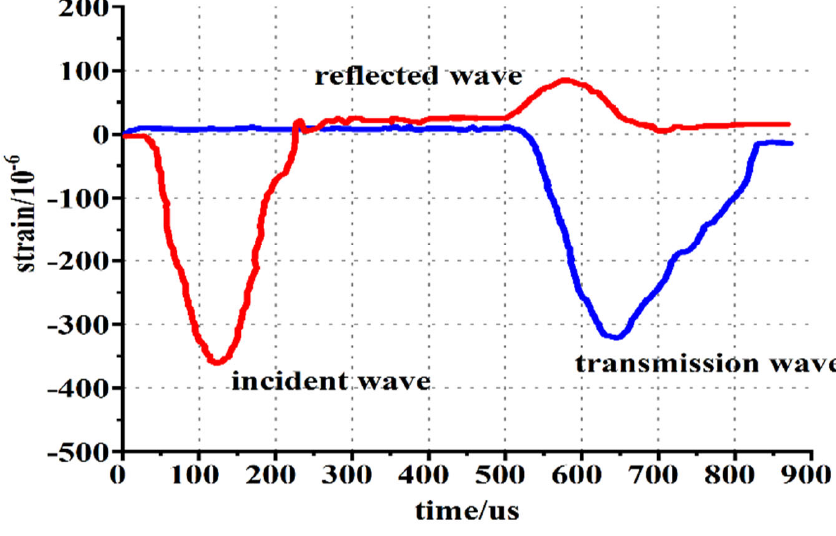
Figure 7. SHPB three − wave strain time − history